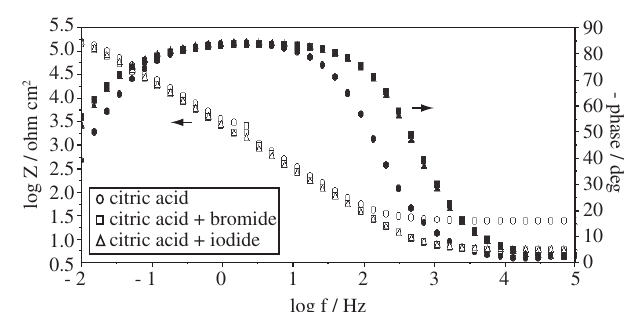
Figure 5. Voltammetric curve of Ti in iodide-containing citric acid from - 1.0 to 4.0 V at 0.02 Vs -1 .